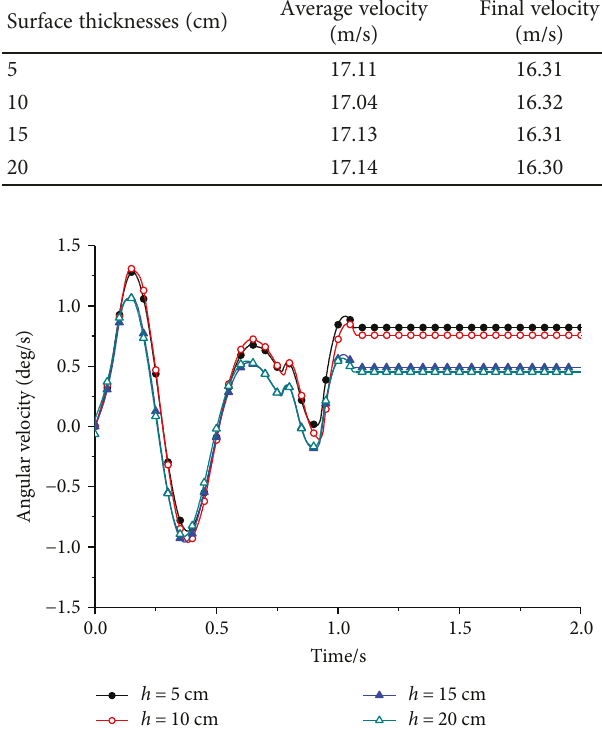
Figure 16: Pitch angular velocity of the missile in di ff erent surface layer thicknesses.